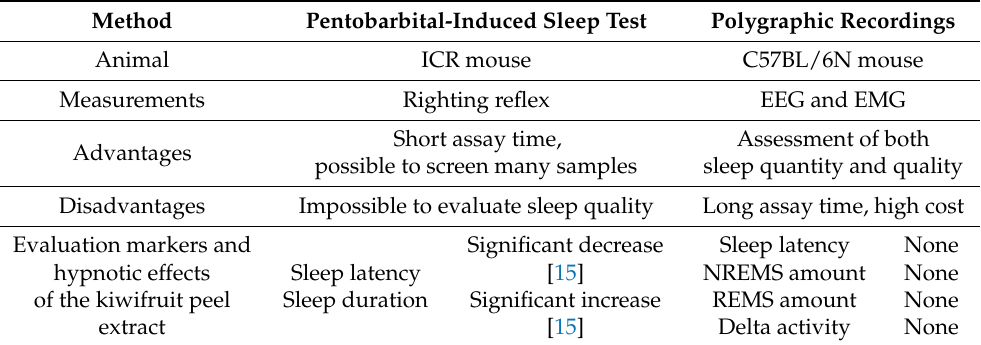
Table 1. In vivo evaluation methods for assessing hypnotic effects and demonstration of hypnotic effects of the kiwifruit peel